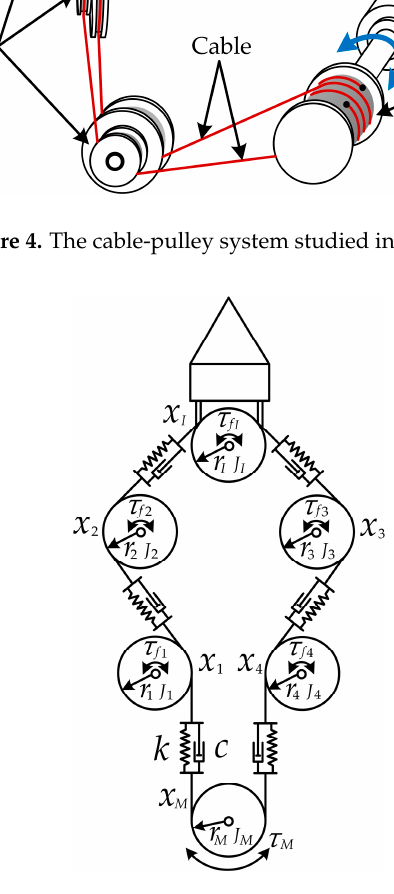
Figure 5. The simplified physical model of the cable-pulley system.